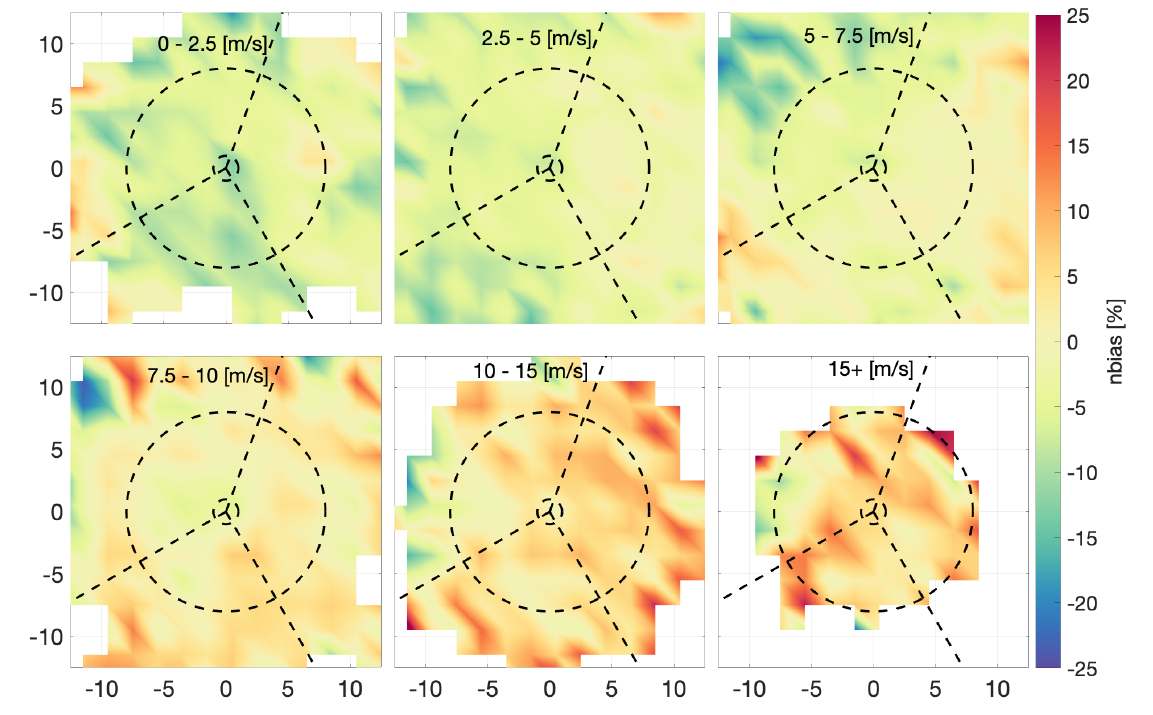
Figure 15. As in Figure 13, each subplot parsed by forward translation velocity.